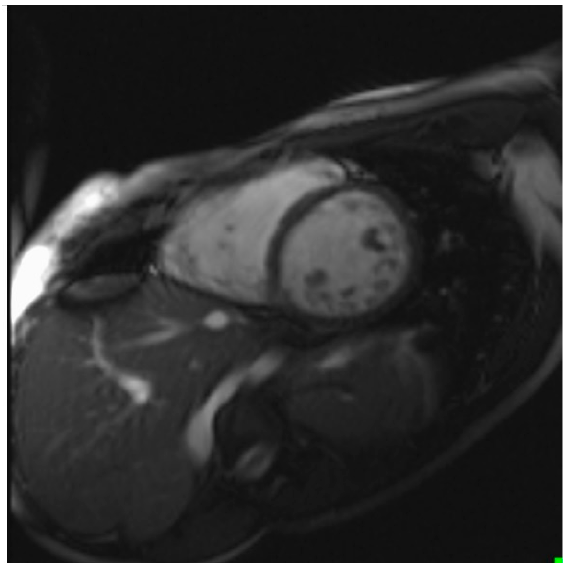
Figure 3. Cardiovascular magnetic resonance study in a patient with LVNC-short axis projection: noncompacted left ventricular layer.